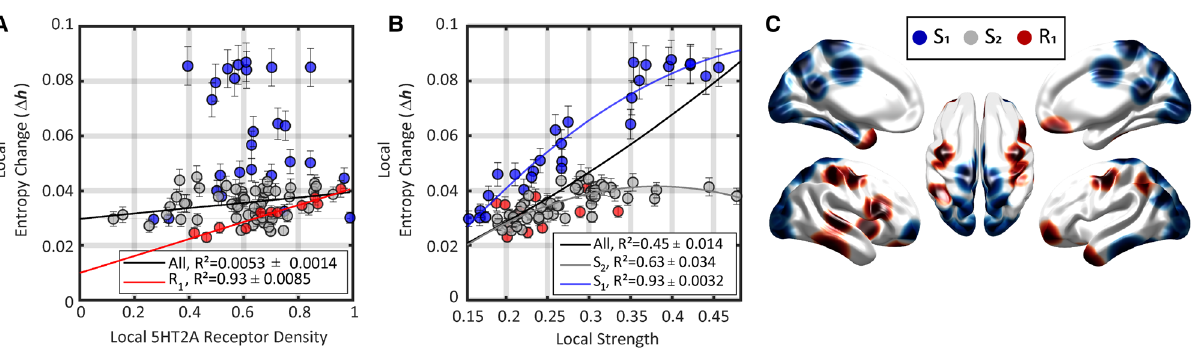
Figure 3. Changes in local entropy are explained best by connectivity strength, then receptor density. ( A ) Changes in entropy were overall independent from receptor density, although ( B ) they were well predicted by the connectivity strength of each region. We split into strength (blue and gray), and receptor dependent groups (red). The S 1 and S 2 groups showed no significant relationship with receptor density, while the R 1 group were highly correlated with it. ( C ) Topographical localisation of the three groups, following the same colour code. S 1 were mainly located in occipital, parietal and cingulate regions, while the R 1 ones were in temporal and frontal